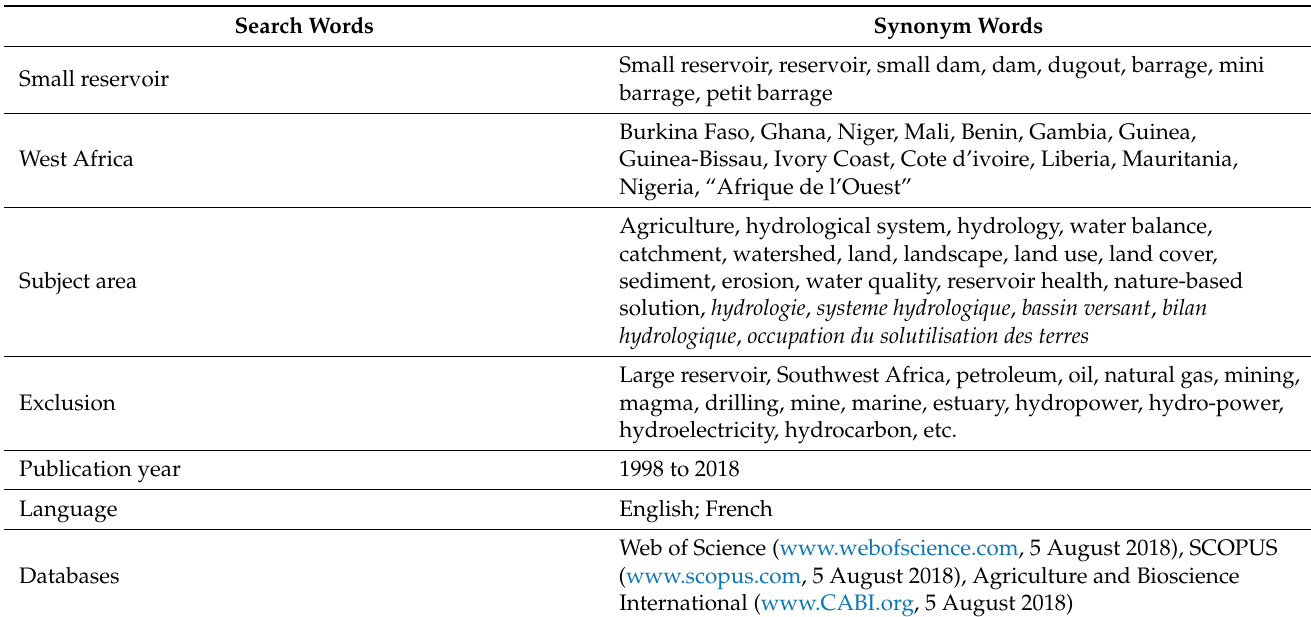
Table 1. Search words used for obtaining relevant